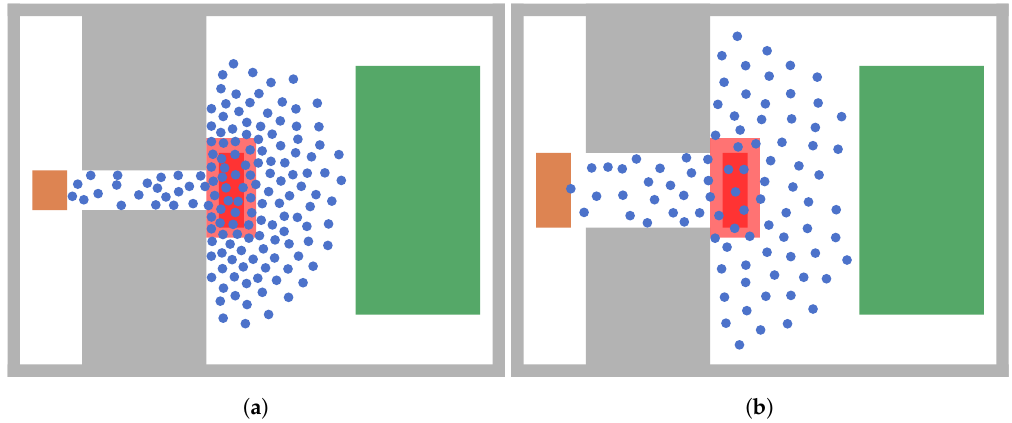
Figure 4. Effect of the uncertain parameters on the distribution of agents in front of and within the bottleneck. ( a ) Simulation where each parameter is set to its lower limit; ( b ) Simulation where each parameter is set to its upper limit.